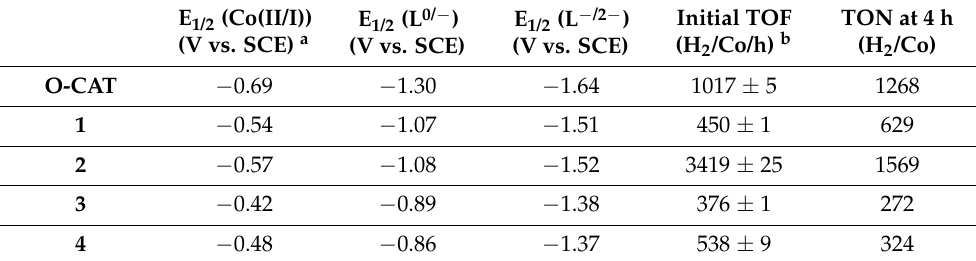
Figure 3. Characterization of the electronic structure of the five Co(II) catalysts. ( A ) Cyclic voltammetry of 1 mM O-CAT and 1 – 4 in CH 3 CN with 0.1 M TBAPF 6 as supporting electrolyte. The solid box highlights the Co(II/I) couple, and the dashed box highlights the ligand reductions. ( B ) Continuous wave X-band EPR spectroscopy of 2 mM O-CAT and 1 – 4 in 1:1 CH 3 CN:CH 2 Cl 2 at 30 K. The simulation of these spectra and magnetic resonance parameters are found in the Supporting Information. Table 1. Summary of cyclic voltammetry data and H 2 generation activity for O-CAT and 1 – 4 . E 1/2